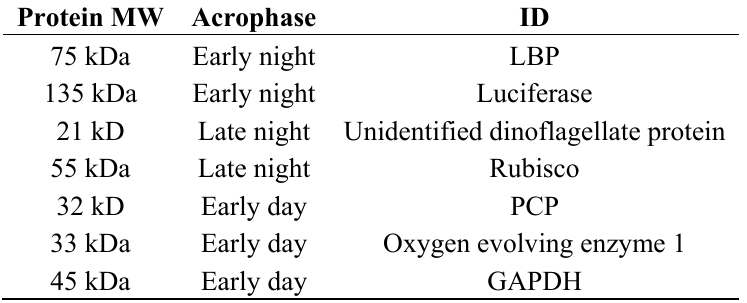
Table 1. Identities and acrophases of proteins exhibiting circadian controlled rates of